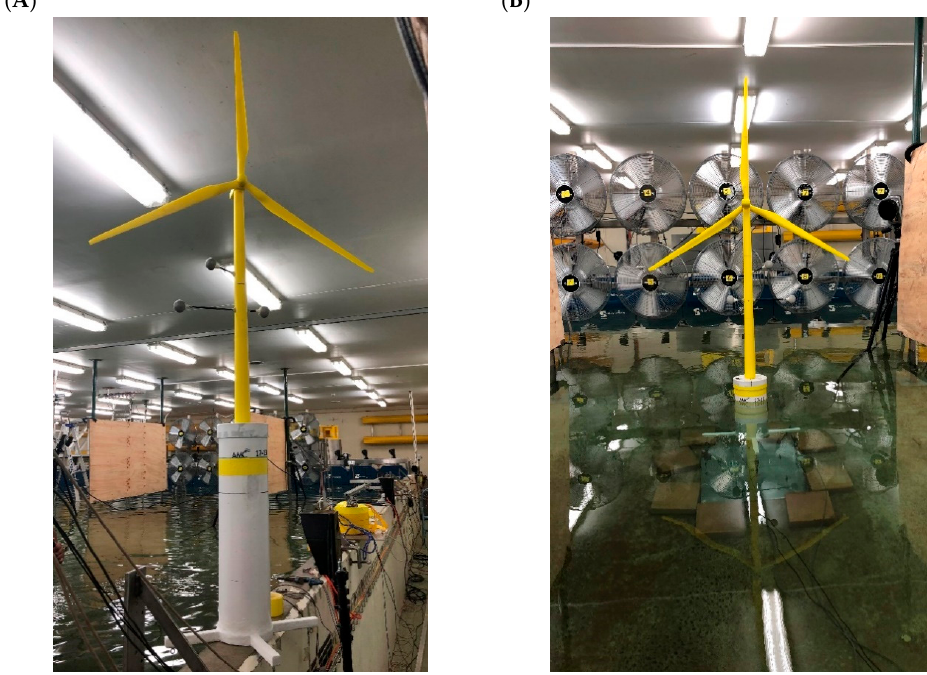
Figure 1. Constructed TLPWT model ( A ), experimental setup ( B ). Table 3. Summary of component materials and